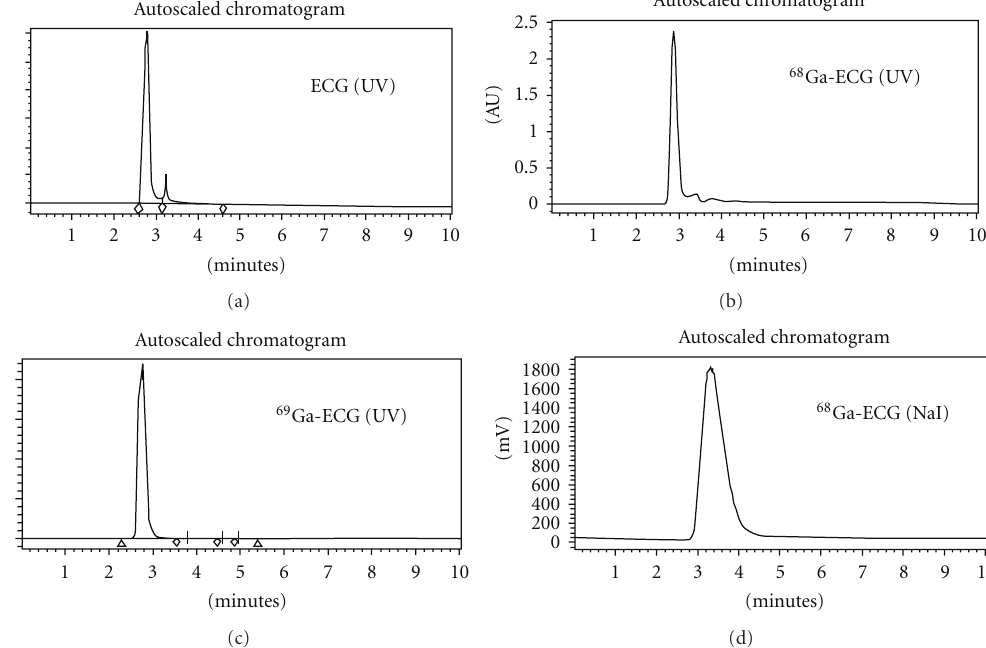
Figure 3: HPLC analysis of 68 / 69 Ga-ECG and ECG (mobile phase: H 2 O/acetonitrile, 9:1 V/V, flow rate: 0.5 mL/min, column: C18-extend (Agilent), UV ABS 210 nm). HPLC analysis of the purity of 68 Ga-ECG was > 96%.